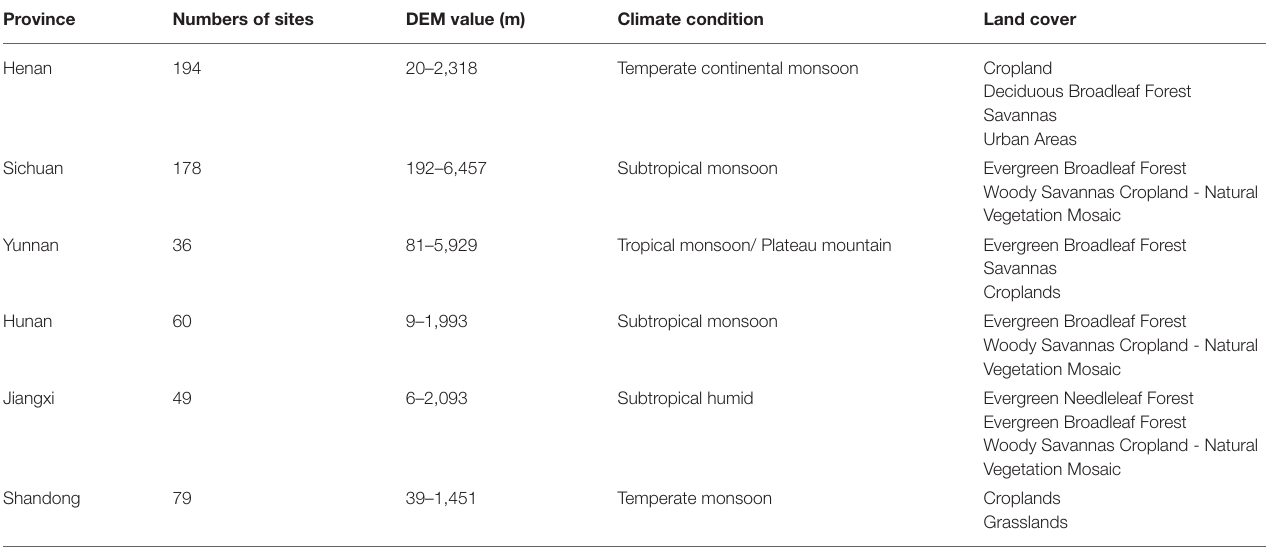
TABLE 1 | Characteristics of the in situ measurements.